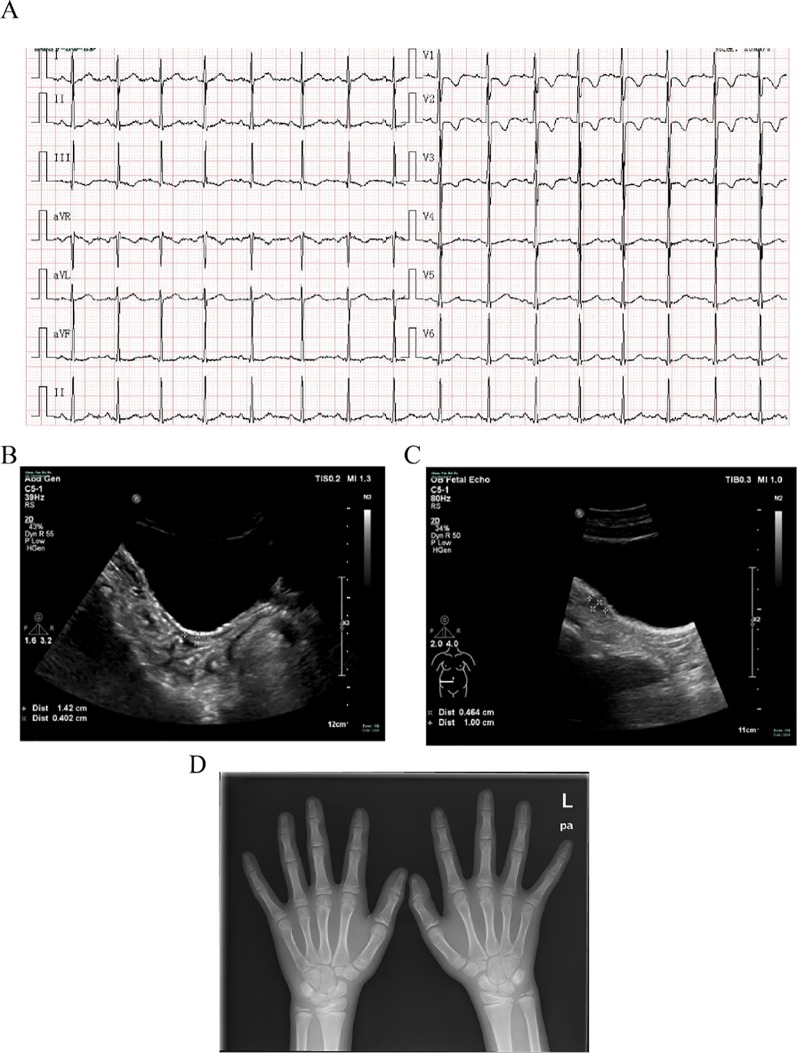
Clinical evaluations. (A) Electrocardiogram revealing signs of hypokalemia with sinus tachycardia and ST-T changes. (B) Pelvic ultrasound showing that the size of the uterus is about 1.4 cm × 0.4 cm × 0.7 cm. (C) Pelvic ultrasound also showing that the size of the suspected right ovary is about 1.0 cm × 0.5 cm × 0.5 cm but the left ovary is undetectable. (D) X-ray imaging of the phalanx, carpal, and radioulnar bones. Greulich-and-Pyle methods are used to evaluate bone age.